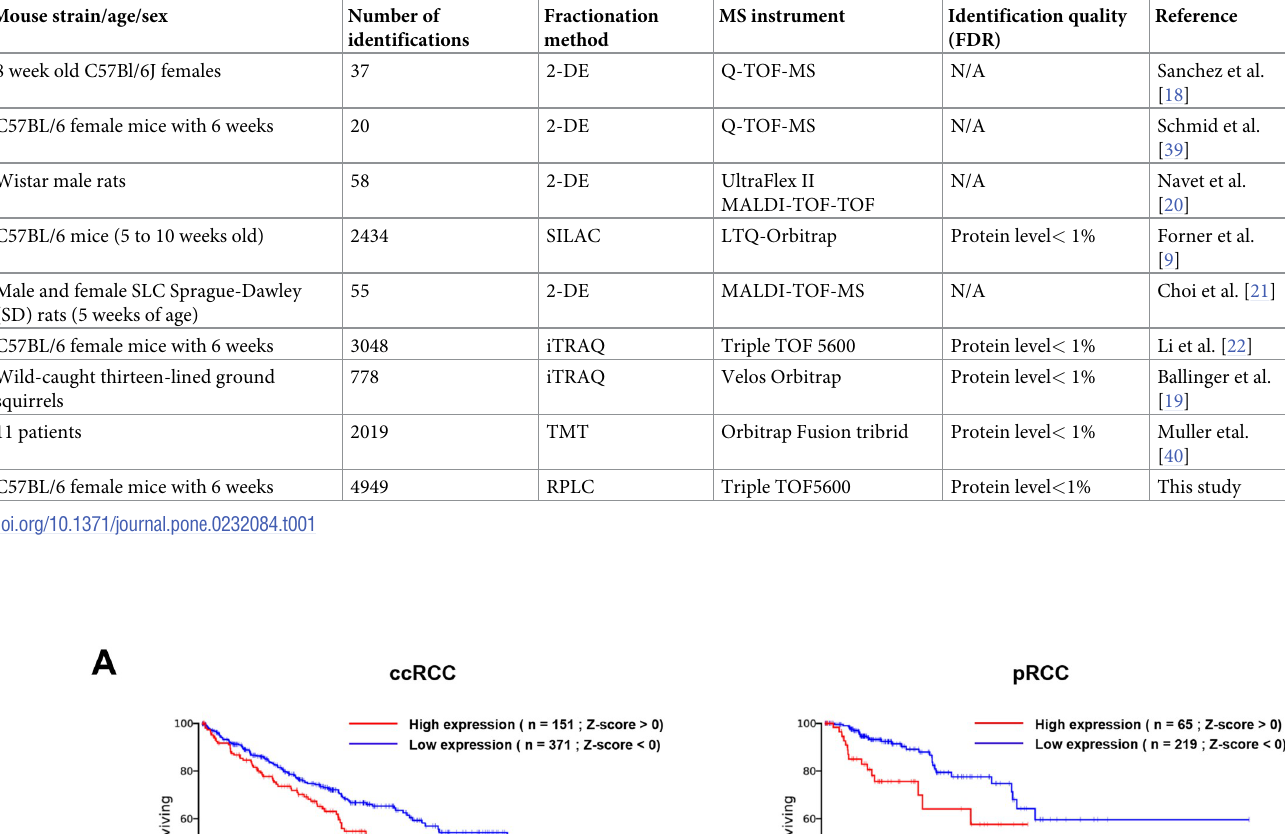
Table 1. Proteomic studies focused on the mouse WAT proteome.